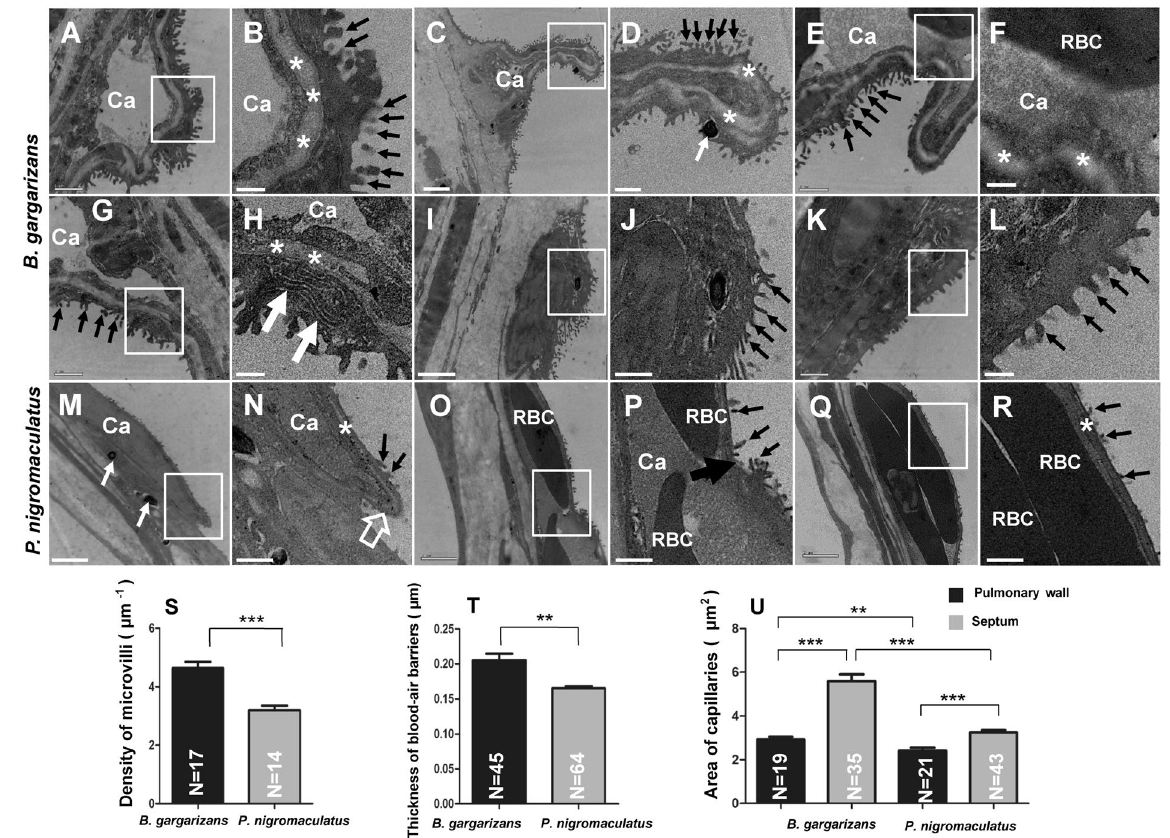
Figure 5. Ultrastructure of pulmonary capillaries in P. nigromaculatus and B. gargarizans by TEM. TEM observation of the pulmonary capillaries in P. nigromaculatus and B. gargarizans . TEM observations of the structures of the capillaries in B. gargarizans ( A–L ) and P. nigromaculatus ( M–R ). The capillary is located in a protruding thick fold ( A,B ) and under the basement membrane ( * ). The capillary (Ca) might swell ( A,B ) or shrink ( C,D ). The red blood cells (RBCs) ( E,F ) do not fill the capillaries. Endoplasmic reticulum and microvilli ( G,H , white thick arrow ). The thin fold does not contain capillaries ( I,J ). Dense microvilli in thin folds ( K,L ). The capillary is located under a sheet with sparse microvilli and a thin basement membrane ( M,N ). Sharp corner (white thick arrow) at the edge of the sheet ( N ). The two sheets interconnect and form a slight dent ( O,P , black thick arrow ). The capillaries contain one ( O,P ) or two layers ( Q,R ) of RBCs that fill the capillaries ( Q,R ). B, D, F, H, J, L, N, P, and R show enlarged images of the boxes in A, C, E, G, I, K, M, O, and Q, respectively. The white thin arrow shows melanosomes, and the black thin arrow indicates microvilli. Scale bar, A, E, G, K, M: 1 μ m; C, I, O, Q: 2 μ m; B, F, H, L, N: 0.35 μ m; D, J, P, R: 0.7 μ m. Density of microvilli (S), thickness of the blood-air barriers (T), and area of capillaries ( U ) in the inflated lungs of both B. gargarizans and P. nigromaculatus . The error bars indicate the SEMs, t test, two-tailed, * p < 0.05, ** p < 0.01, *** p <